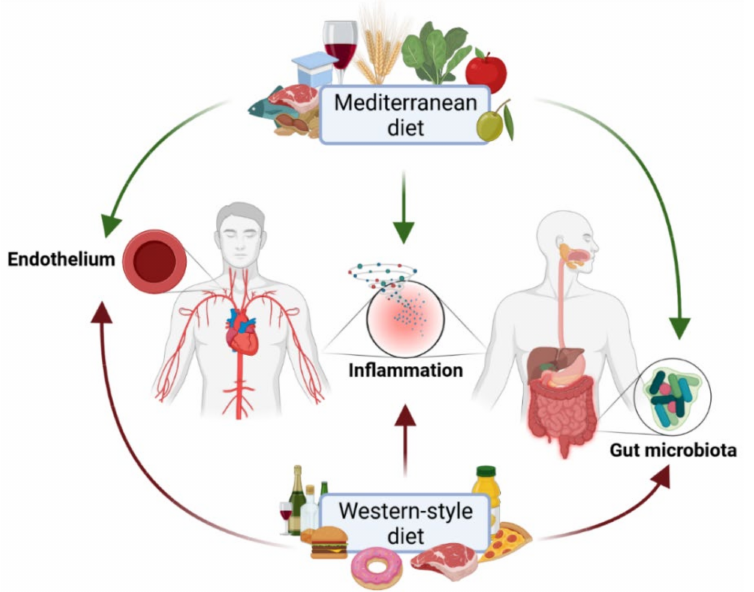
Figure 1. The influence of Western-style and Mediterranean diets on the cardiovascular risk in inflammatory bowel